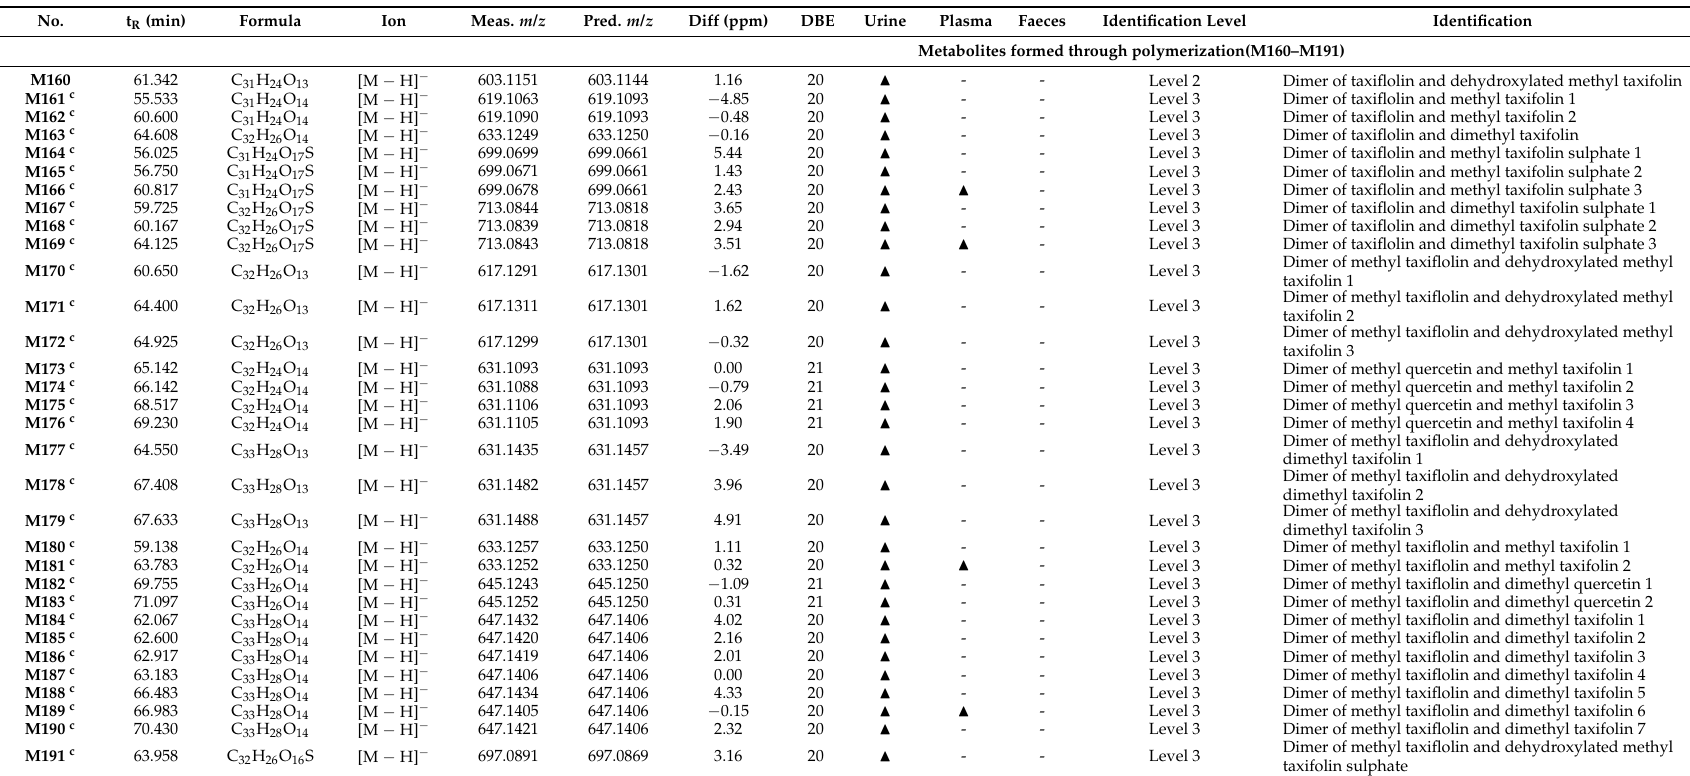
- - Level 3 Dimer of methyl taxiflolin and dehydroxylated methyl taxifolin